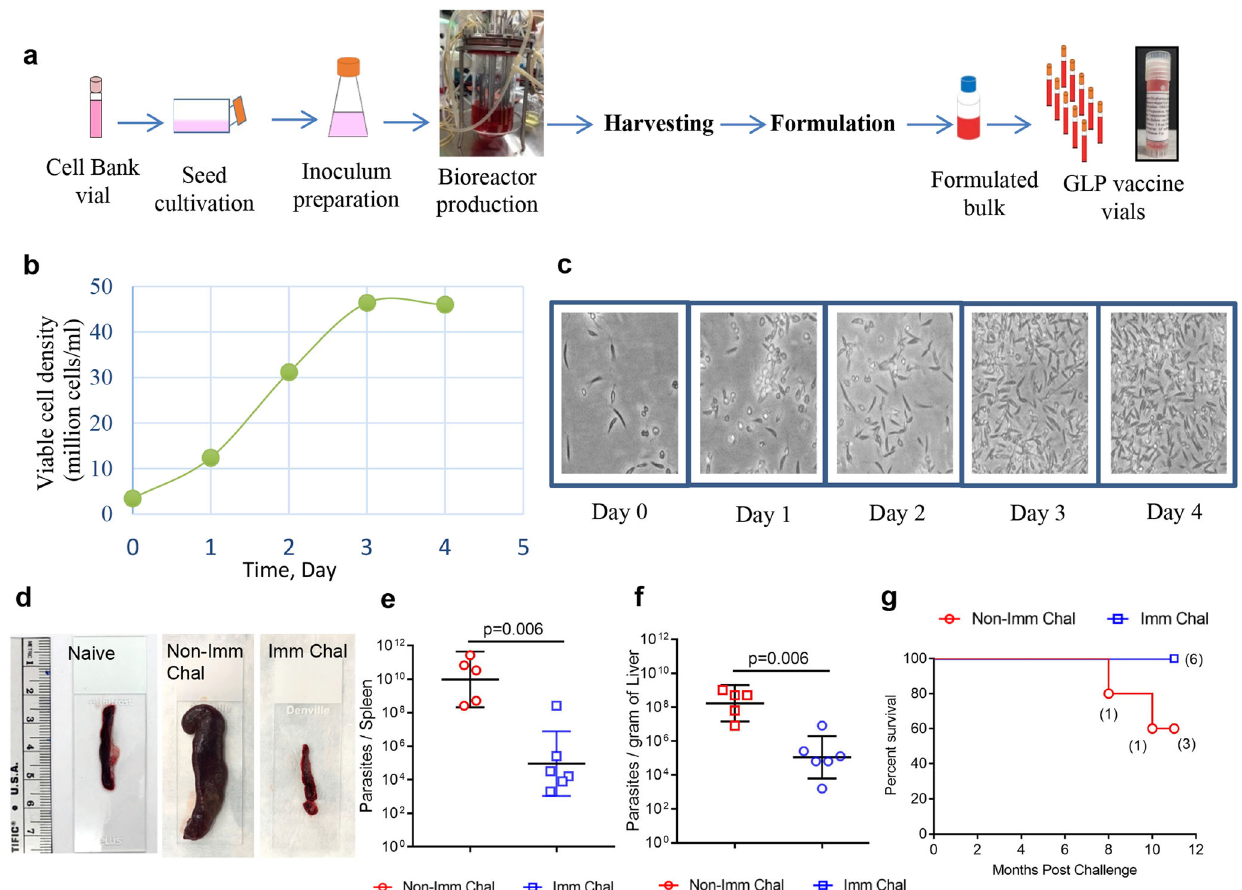
Fig. 5 GLP-grade LmCen − / − parasites immunization confers protection in hamsters. a Production of GLP-grade LmCen − / − parasite. b Growth behavior of parasite during bioreactor cultivation. c Morphology (magni fi cation ×400) of the parasite during 4 days of bioreactor cultivation. d Photographs (left panel) of representative spleen samples of both LmCen − / − - immunized and nonimmunized hamsters following 10 months post challenge as well as one age- matched naive hamster is shown. e , f Parasite load in the spleen ( e ) and liver ( f ) of hamsters either immunized with GLP-grade LmCen − / − (Imm Chal, n = 6) parasites or age-matched nonimmunized control (Non-Imm Chal, n = 5) were determined following 10 months of post challenge with L. donovani - infected sand fl ies. Results plotted as geometric means with 95% Cl from one experiment ( p values were determined by Mann – Whitney two-tailed test). g Kaplan – Meier survival curves of GLP-grade LmCen − / − - immunized hamsters (Imm Chal; blue lines, n = 6) following challenge with L. donovani- infected sand fl ies and compared with age-matched nonimmunized-challenged group (Non-Imm Chal; red lines, n =